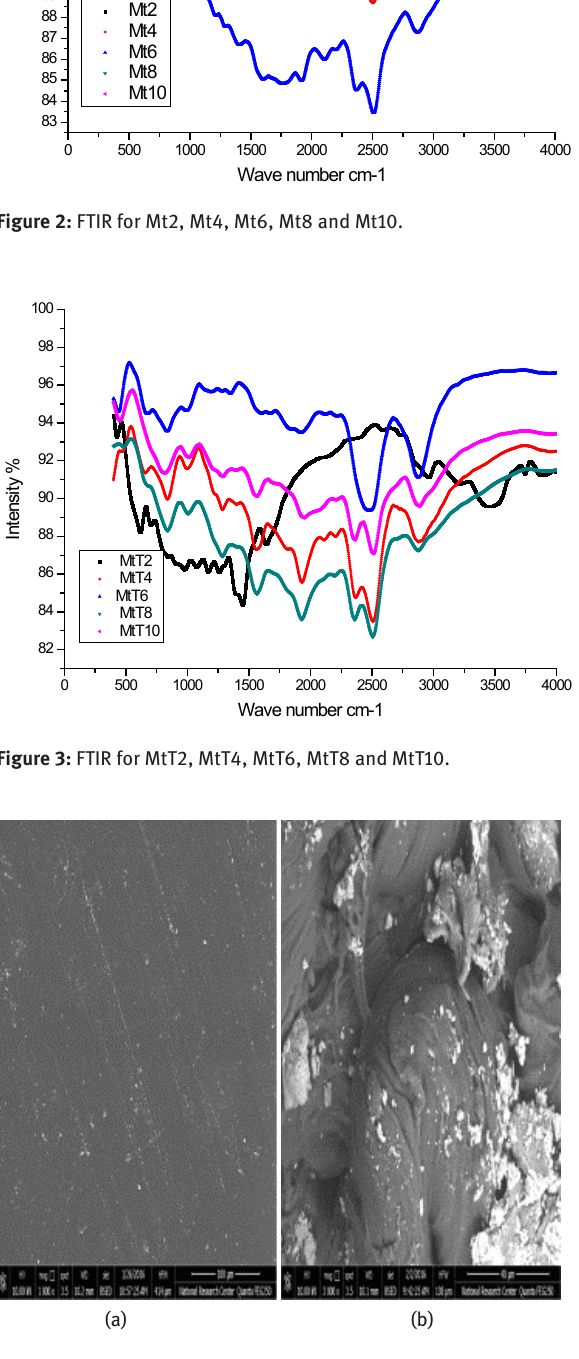
Figure 4: SEM of a) PP and b) PP/10%APP. (The magnification equal 3000).